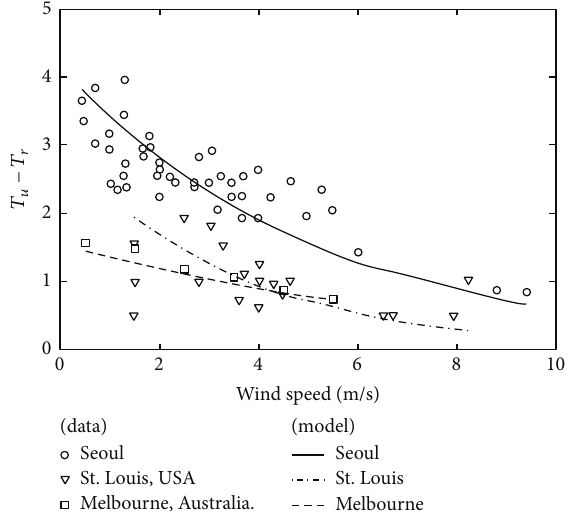
Figure 2: The effect of the wind speed on the UHI intensity in Seoul, Korea, St. Louis, USA, and Melbourne, Australia. The theoretical lines are obtained using (3). (𝑇 𝑢 −𝑇 𝑟 ) is the UHI intensity defined as the maximum difference in the temperatures in the urban and rural locations.